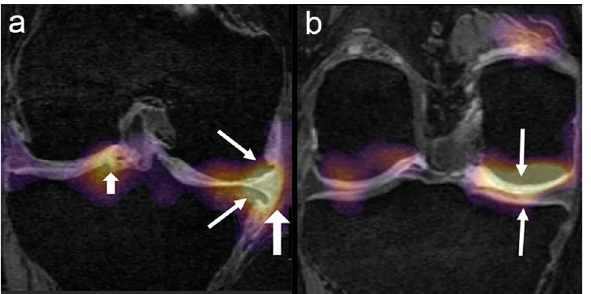
Figure 3. ( a ) Baseline coronal DESS reformatted image of a case subject (WOMAC pain score—9, stiffness score—39.3, disability score—5) with TKR shows regions of discriminative high activation along the peripheral bone-cartilage interface of the medial femoral condyle and medial tibia plateau in areas of osteophyte formation (thin arrows), within the extruded medial meniscus (thick long arrow), and within the lateral tibial spine and intercondylar notch (thick short arrow). ( b ) Baseline coronal DESS reformatted image of a control subject (WOMAC pain score—0, stiffness score—0, disability score—0) without TKR shows regions of discriminative high activation along the central bone-cartilage interface of the medial femoral condyle and medial tibia plateau in areas of healthy appearing cartilage (arrows).